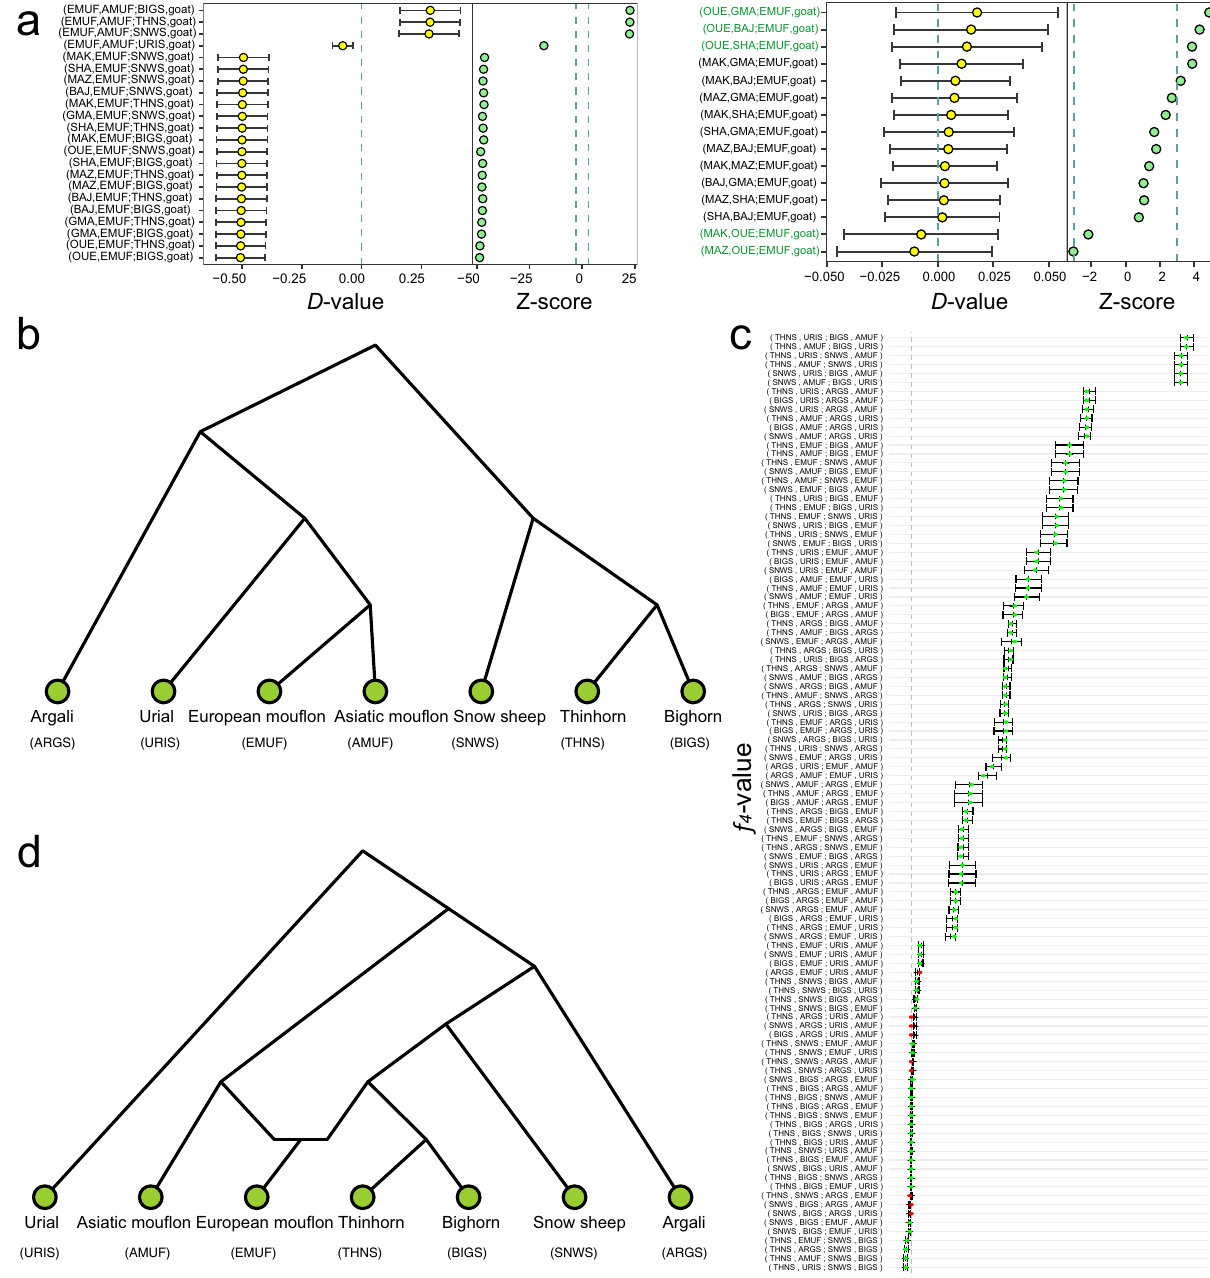
Fig. 4 Admixture graph fi tting for introgression from the Pachyceriforms into European mou fl on. a D -statistics of European mou fl on (EMUF) with the Pachyceriforms [snow sheep (SNWS), bighorn (BIGS), and thinhorn sheep (THNS)]. b Prior phylogeny of wild species in Ovis genus. c Goodness of fi t of f 4 -statistics. d Admixture graph. Source data for a , c were presented in Supplementary Data